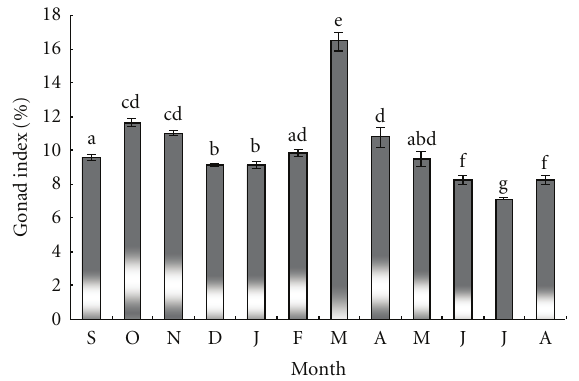
Figure 3: Monthly variation of carbohydrate levels in sea urchin gonads. Columns with the same letter are not significantly di ff erent.